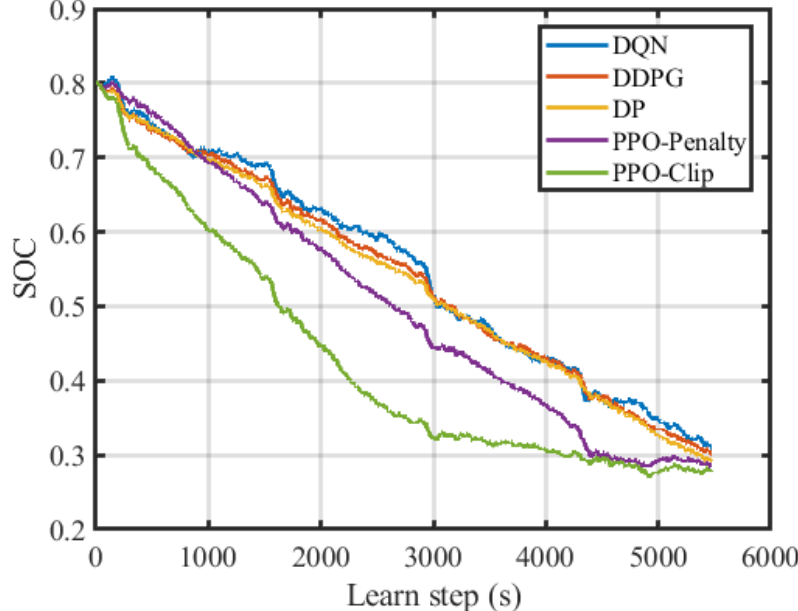
Figure 13. Battery SOC trajectories in 4 × UDDS.